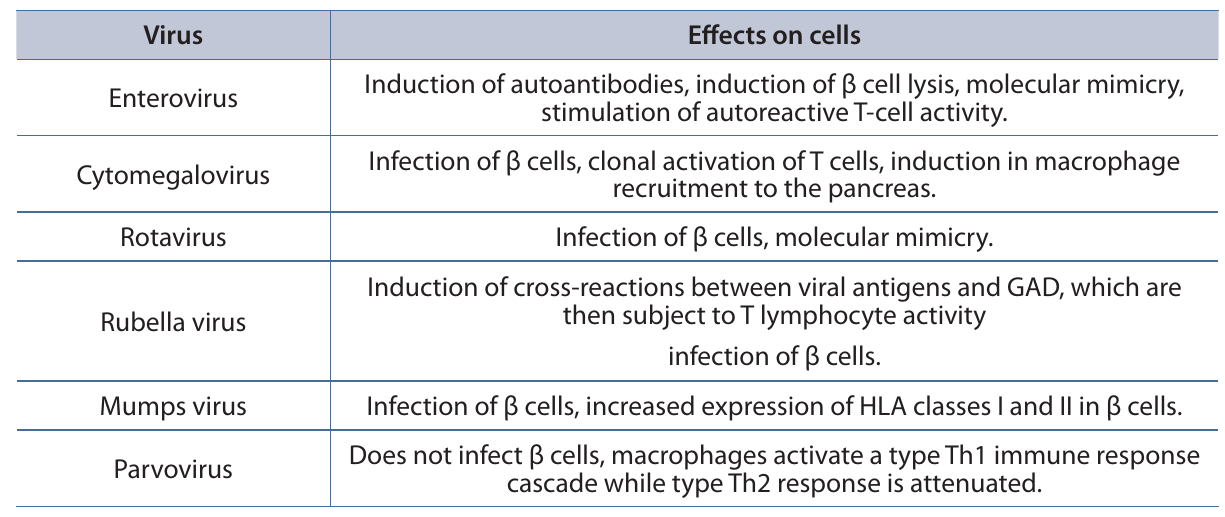
cascade while type Th2 response is